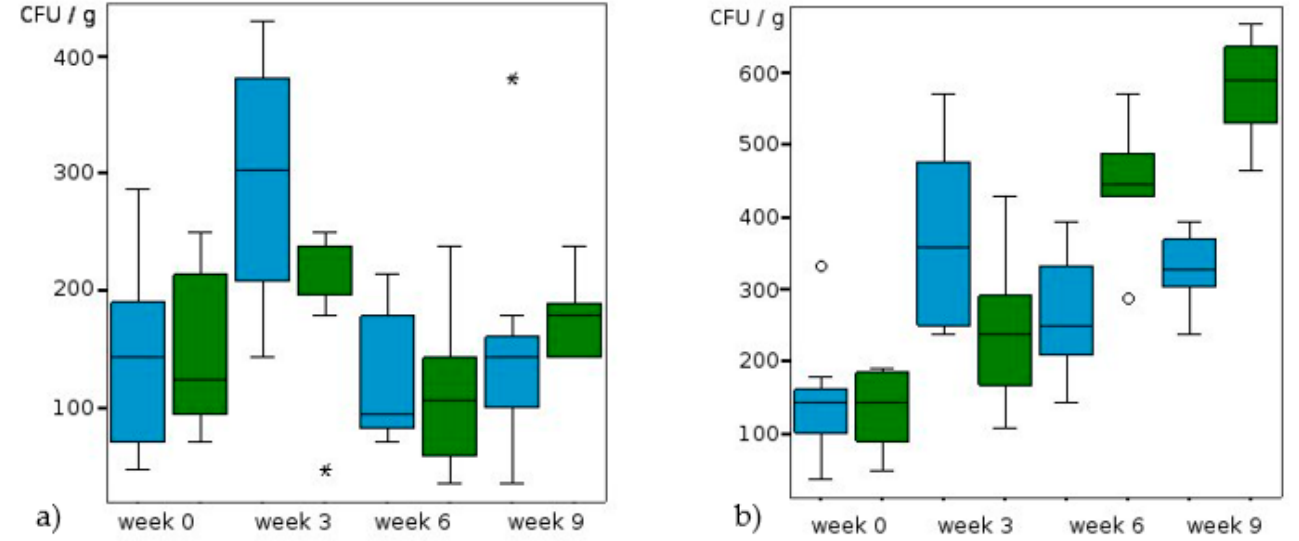
Figure 2. Alteration of CFU/g soil (dw) at ( a ) 18 ◦ C and ( b ) 25 ◦ C and different KNO3 concentrations (blue: 2%, green: 4%, stars: extreme values, circles: outliers).